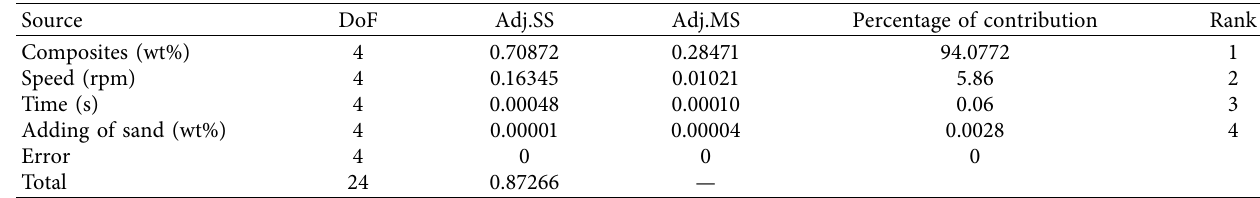
Figure 7: Best and mean values of output results of abrasive wear. Table 12: ANOVA results (erosion